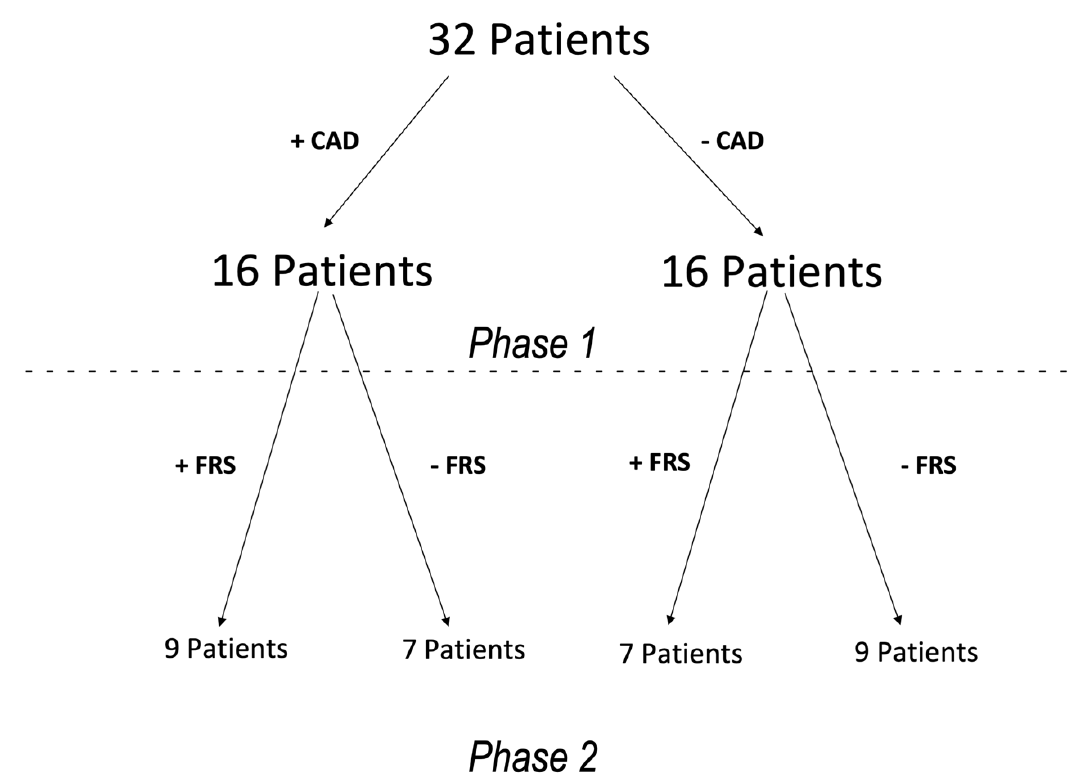
Figure 1. Diagram showing the 32 patients stratified on the basis of presence or absence of CAD (phase 1) and high or low FRS (Phase 2). CAD—Coronary Artery Disease. FRS—Framingham Risk Score.